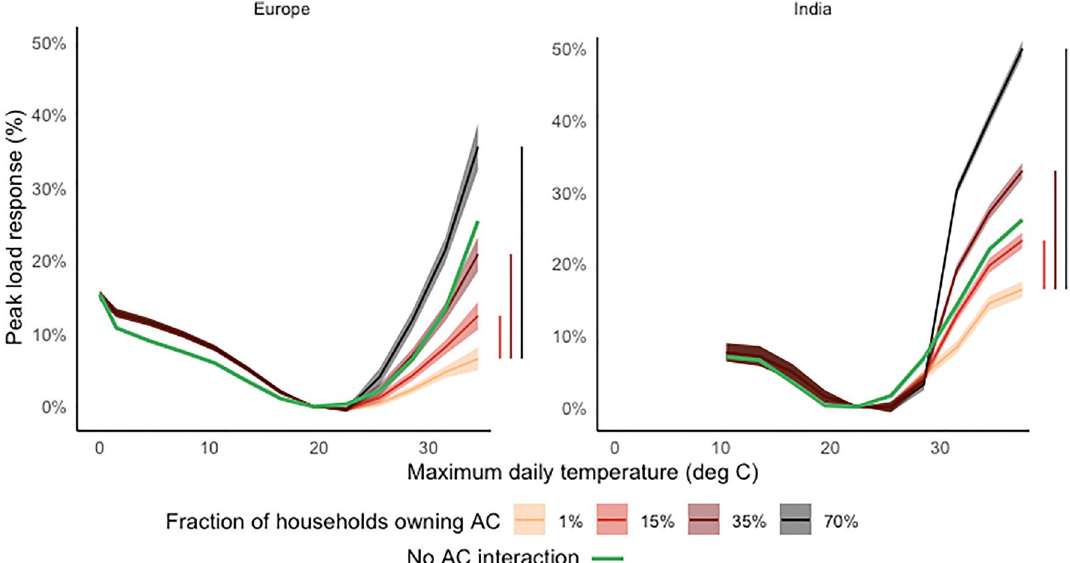
Figure 2. Response of per capita daily peak load to maximum daily temperatures. Shaded areas represent the 95% Confidence Interval (CI) of the empirically estimated response (see “Methods”). Vertical bars show the difference between the estimated response when AC > 0% and when AC ≈ 0% for a > 33 ◦ C ( > 36 ◦ C ) day in Europe (India), indicating the contribution of a given AC prevalence level once the effect of energy-intensive durable goods other than AC is filtered